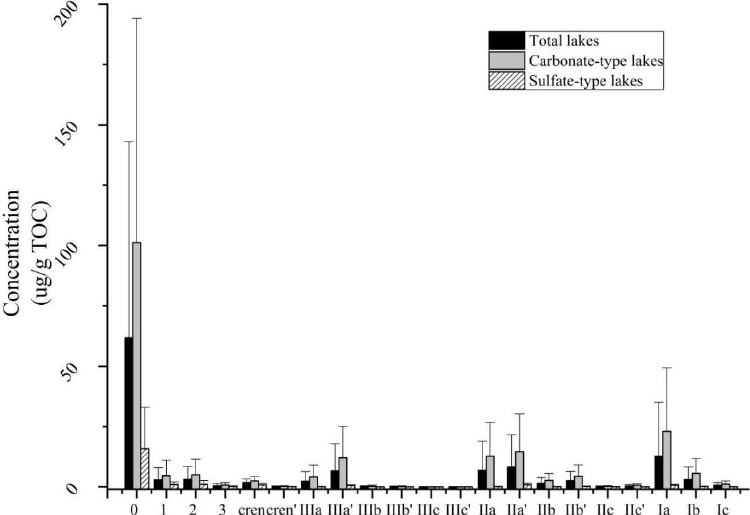
Figure 2. Concentrations of individual GDGTs in surface sediments.